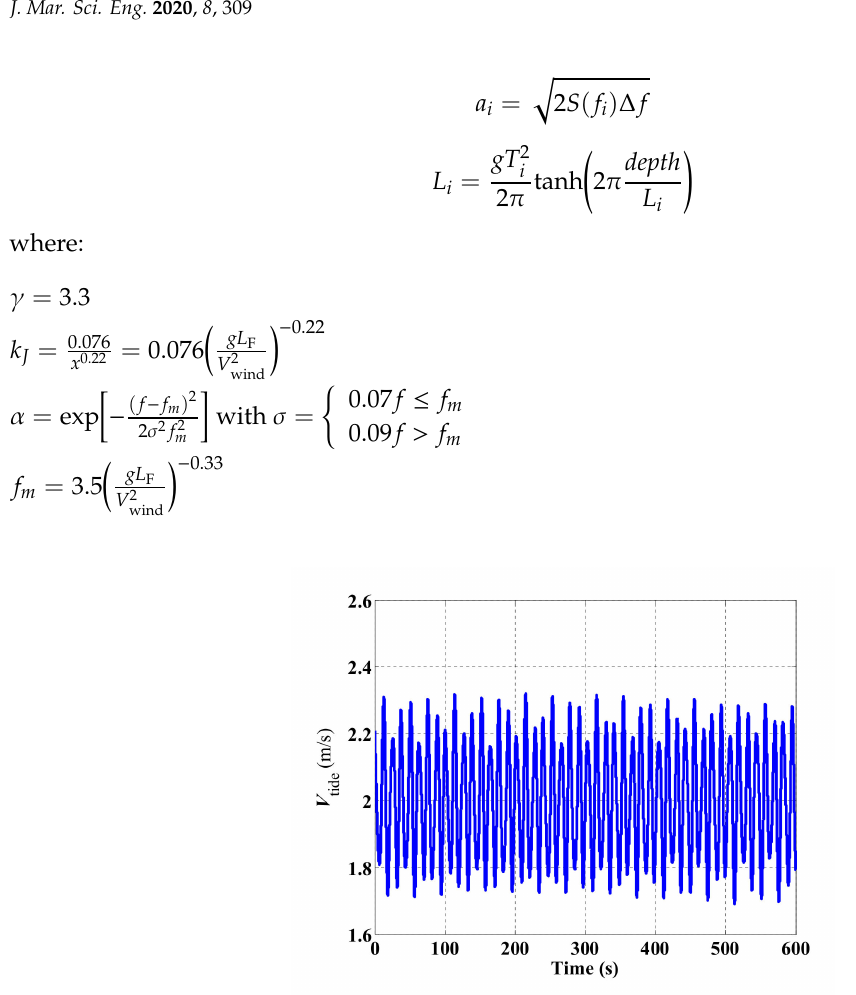
Figure 10. Marine tidal current speed regarding swell e ff